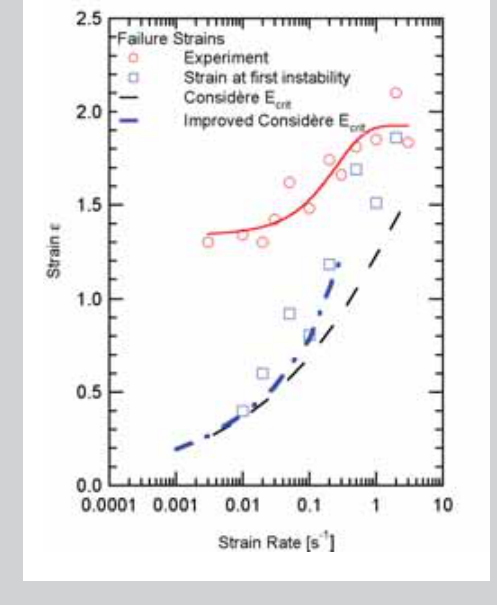
Figure 7: Two different measures of extensibility plotted against the imposed strain rate. Square symbols denote the , point of first instability E crit open circles denote the final rupture strain E . Dotted fail lines are predictions for onset of instability using two different criteria from Considère and from Hutchinson and Obrecht [41]. The solid line shows the results of numerical compu- tations. Figure 8: a) Stress relaxation showing power-law–like behavior (stresses are shifted to account for rheological age- ing). b) Stress relaxation curves can be scaled to lie on a sin- gle curve through a damp- ing function. c) The damping function h( g ) as a function of the imposed strain amplitude (q =13.51, k =